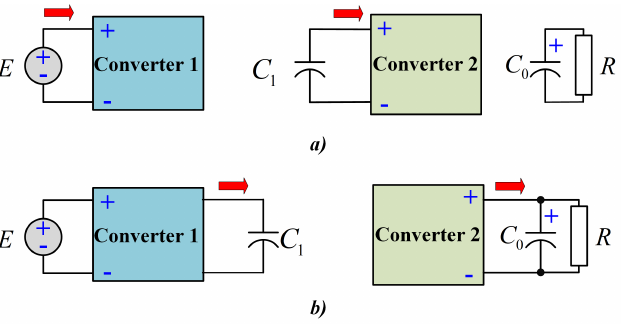
Figure 2. Power flows of the QBC-SC: ( a ) Equivalent scheme when both inductor are storing energy, and ( b ) equivalent scheme when both inductor are delivering energy.